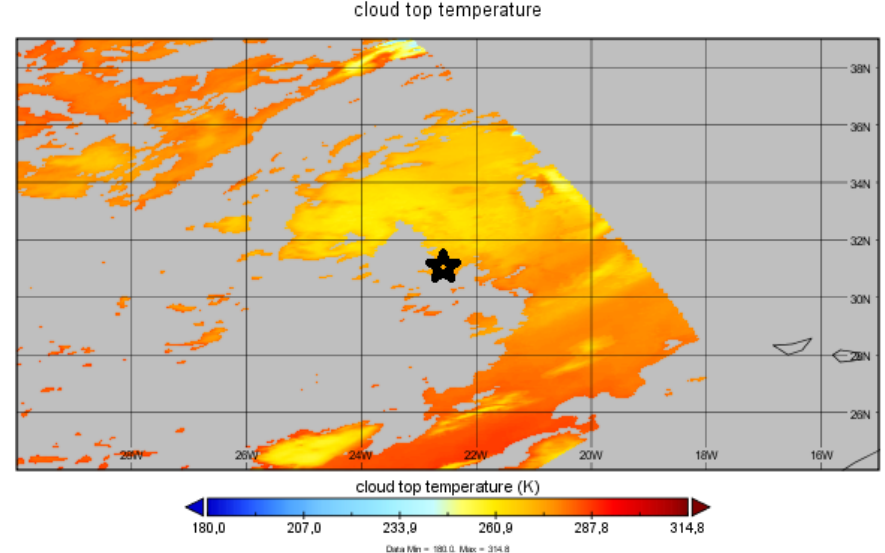
Figure 8. Cloud top temperatures by GOES-13 on July 28th, 2017 at 00:45 UTC near the TUS FOV centered at the event shown in Figure 7 position. The black star shows the position of the